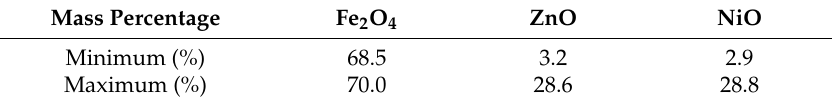
Table 5. Material mass composition percentage of NiZn soft ferrites.